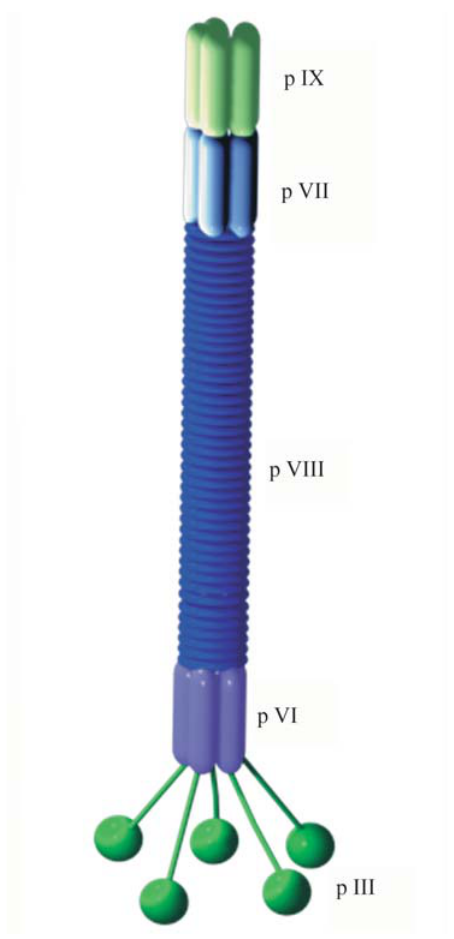
Figure 1 - Phage structure. PIII, pVI, pVII, pVIII and pXIX represent phage proteins. Exogenous peptides are expressed or “displayed” usually on pIII or